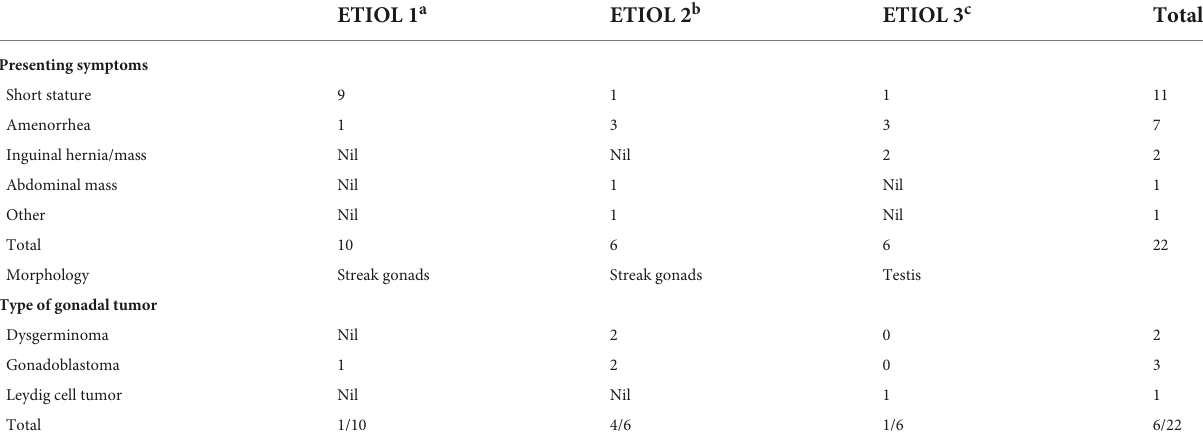
TABLE 3 Presenting clinical features and number of gonadal tumors by